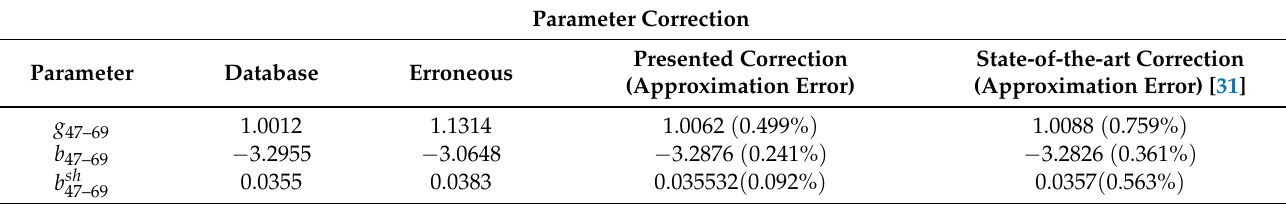
Table 4. Corrected parameters using the updated parameter correction Jacobian matrix τ up .